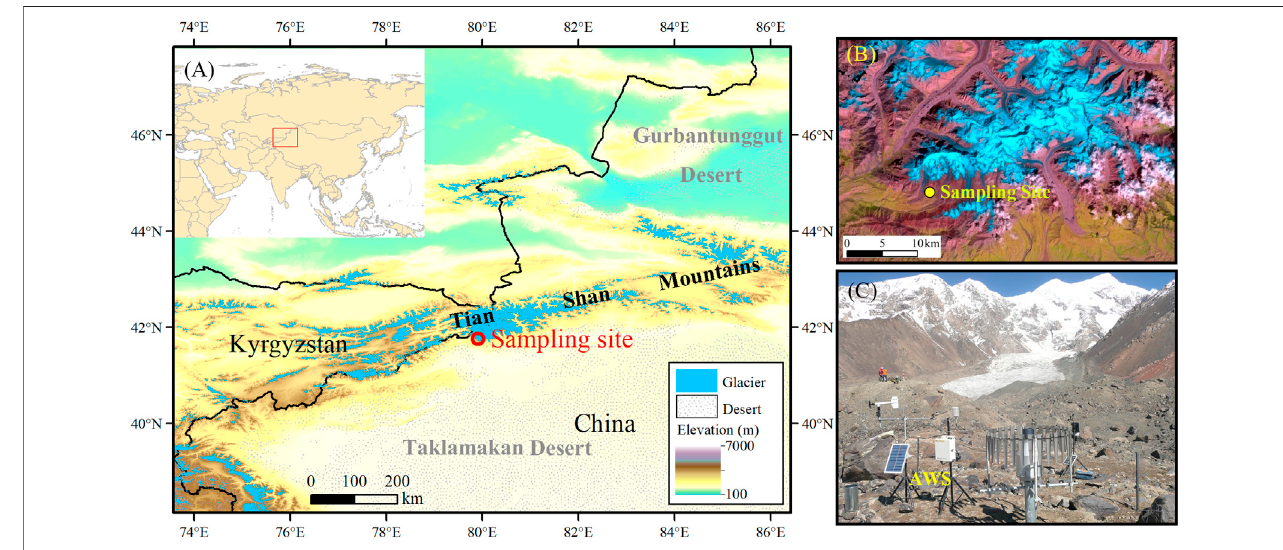
FIGURE 1 | Map showing the location of Qingbingtan Glacier No. 72 (A,B) and automatic weather station at the end of glacier 72 (C) .